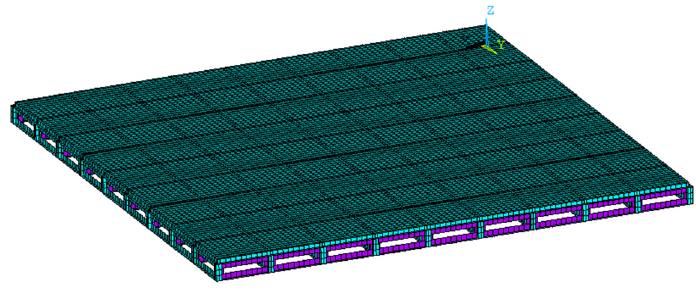
Figure 3. Finite element model of Vierendeel sandwich plate.